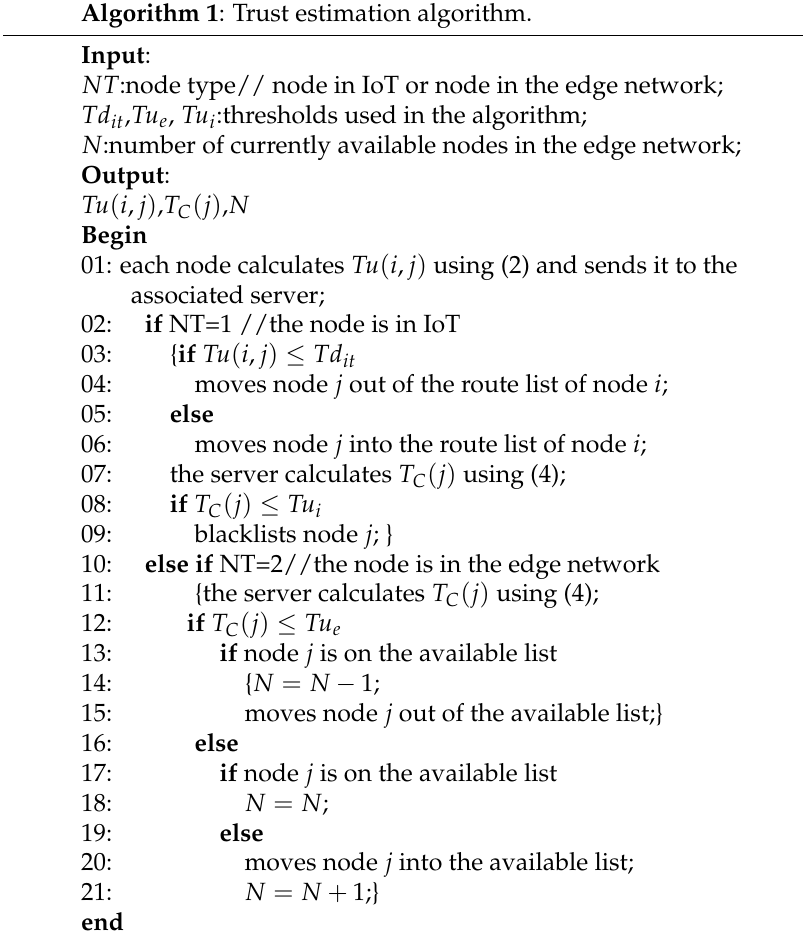
Algorithm 1 : Trust estimation